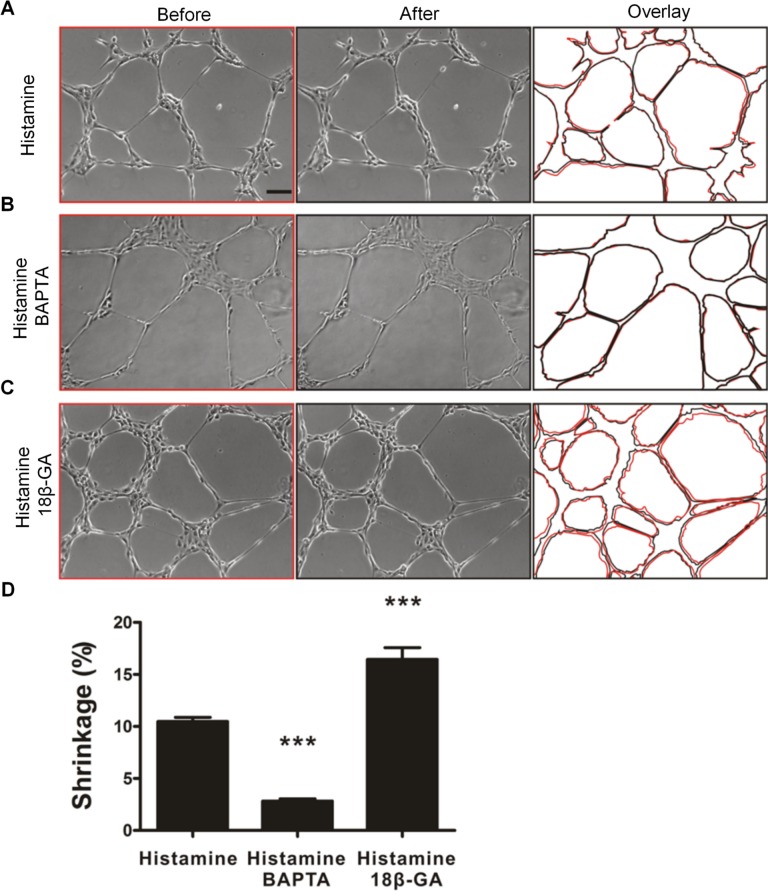
Calcium signaling regulates histamine-mediated contraction in capillary-like networks.(A-C) Shrinkage of capillary-like networks after treatment with (A) histamine, (B) histamine and BAPTA, and (C) histamine with 18β-GA. Left and middle columns indicate bright-field images of the networks before and after treatment. Right column shows overlays of cell structure profiles before (red) and after (black) histamine treatment. Scale bar, 100 μm. (D) Quantification of the relative shrinkage area. Data are representative from seven independent experiments (Bonferroni's multiple comparison test; ***, P<0.001).